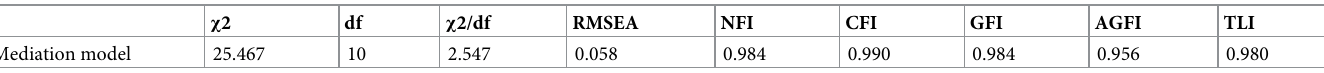
Table 4. Structural equation modeling fit